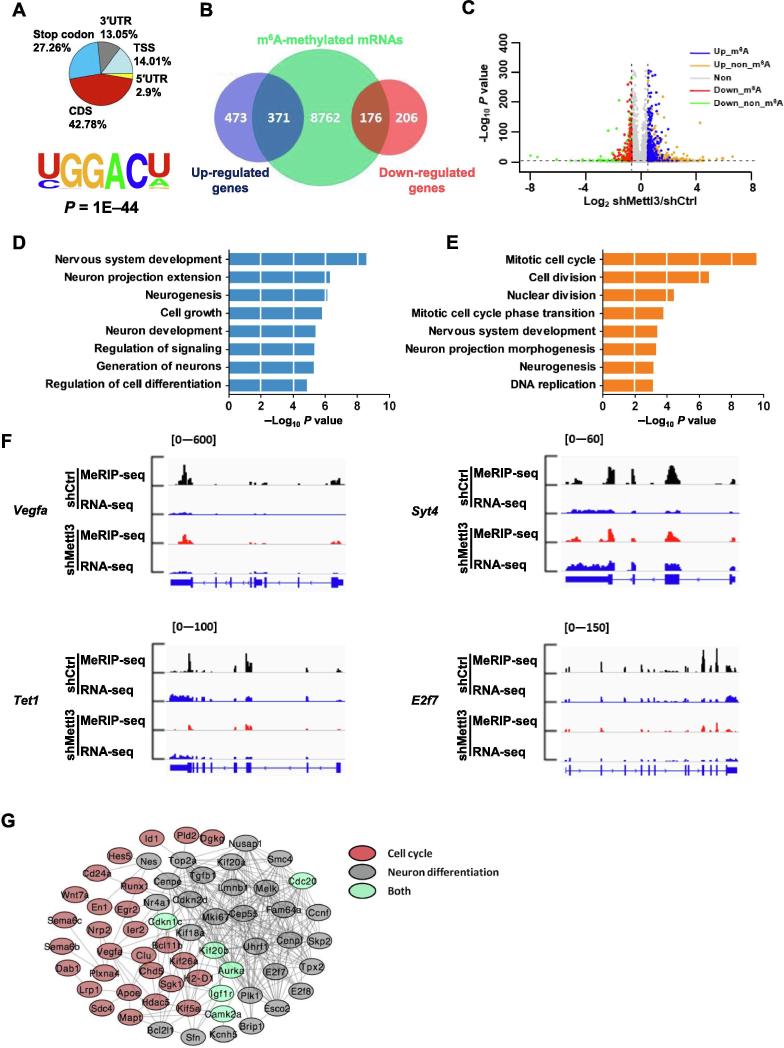
Mettl3-mediated m6A regulates gene expression in proliferating aNSCsTranscriptome-wide distribution of m6A peaks in Mettl3 KD samples (n = 2) (A). Venn diagram illustrating the up-regulated and down-regulated genes and m6A-modified transcripts in Mettl3 KD samples (B). Volcano plot showing differentially expressed genes between control and Mettl3 KD samples (C). GO analysis of m6A-tagged up-regulated (D) and down-regulated (E) transcripts in Mettl3 KD samples. Four examples of IGV tracks showing that the enrichment of m6A in several transcripts, which are related to neurogenesis and neuronal development, were significantly decreased in Mettl3 KD samples (F). RNA-seq reads were used as input. The interaction network showing differentially expressed transcripts with m6A modification. Genes related to cell cycle and neuronal differentiation are marked in red and gray, respectively, whereas genes related to both processes are marked in green (G).